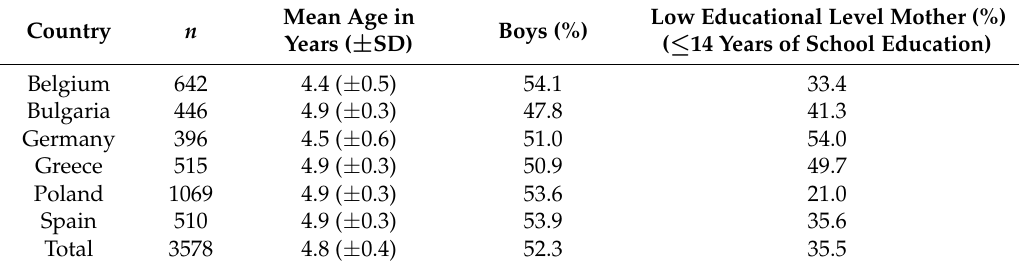
Table 1. Descriptive statistics of preschoolers across the participating European countries.